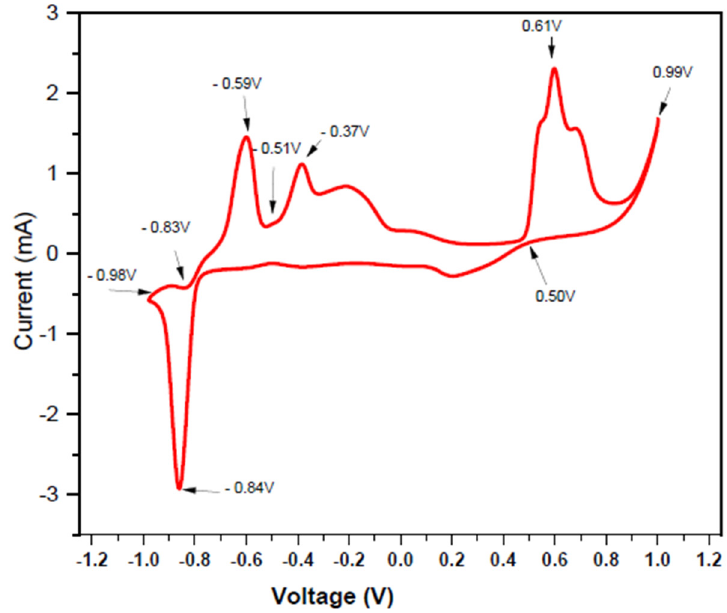
Figure 5. Cyclic Voltammetry of all the solutions when they are mixed together. Pt is used as working electrode, Pt mesh as a counter electrode and Ag / AgCl as reference electrode for sweep rate of 50 mV / s from − 1.0 V to + 1.0 V at the current limit of 1 mA by using K-Lyte 1.2 Potentiostat. Cyclic Voltagram of 0.1 M Pb(NO 3 ) 2 , 0.1 M TeO 2 , 2 M KOH, 0.2 M trisodium citrate (TSC), and 0.8 M KBH 4 were dissolved in sequence in 50 mL double distilled deionized water.